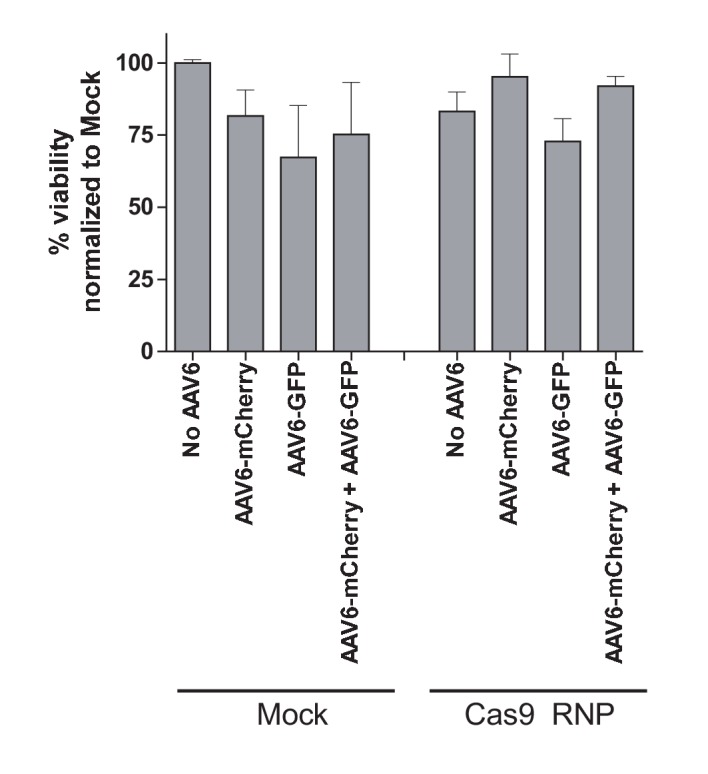
Toxicity assessment of biallelic integration at the CCR5 locus in primary human T cells.Human primary T cells were isolated from buffy coats and stimulated for three days using anti-CD3 and anti-CD28 antibodies. Cells were then electroporated with CCR5-targeting Cas9 RNP and transduced with two CCR5-specific rAAV6 donors encoding GFP and mCherry, respectively, either alone or in combination. Cell viabilities were measured at Day two post-electroporation by Trypan Blue exclusion assay (N = 2 different buffy coat-derived T cells).